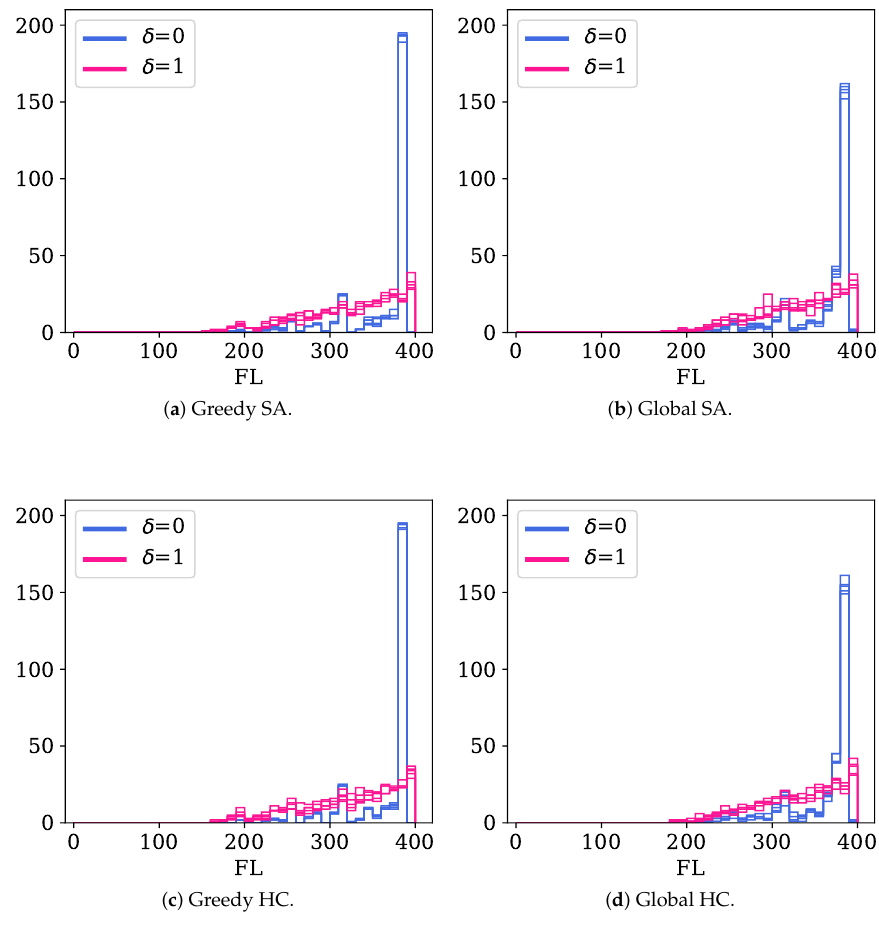
Figure 8. Distribution of FLs for different optimization methods. Table 3. Analysis of the FLs used for the different algorithms and δ = 0.